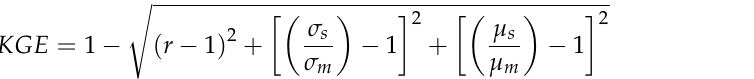
Table 2. Parameters Included in SWAT Model and Initial Ranges. SWAT Parameter Differs By min max CN2 * Land use − 0.5 0.1 SOL_AWC * Soil Texture − 0.1 0.5 SOL_K * Soil Texture − 0.5 0.5 SOL_BD * Soil Texture − 0.5 0.1 EPCO * − 0.3 0.3 ESCO * Land use − 0.3 0.3 GW_DELAY 0 100 GWQMN 0 1000 RCHRG_DP 0 1 GW_REVAP 0.02 0.2 REVAPMN 0 500 SURLAG 0